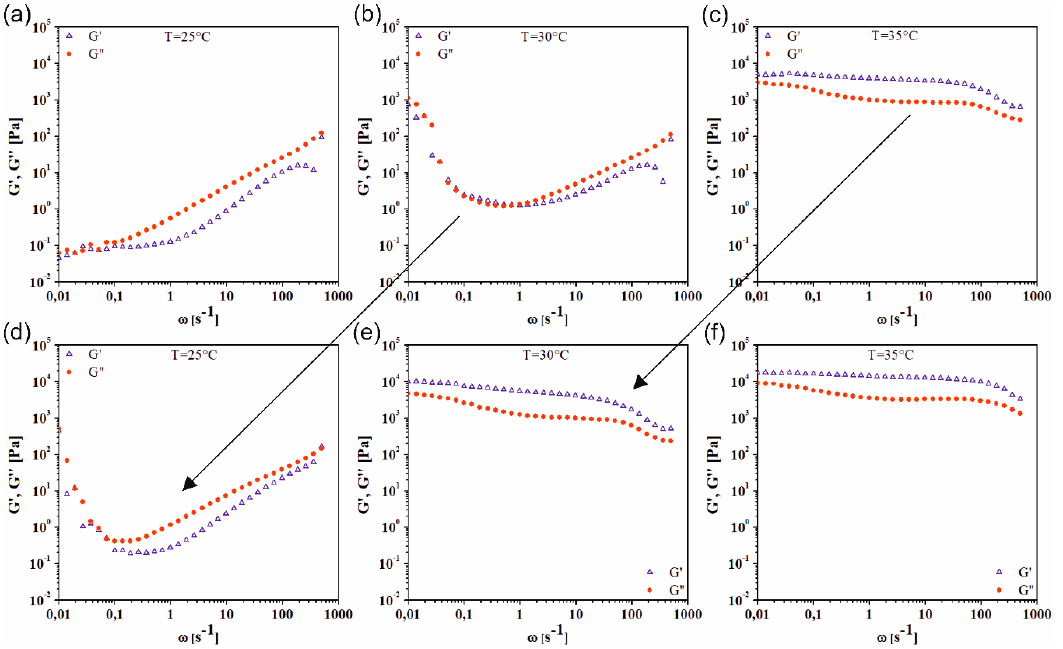
Figure 6. Comparison of experimental curves for storage G’ and loss G” moduli for sample 3 ( a – c ) and sample 3CC ( d – f ) at 25 °C, 30 °C and 35 °C. sample 3CC ( d – f ) at 25 ◦ C, 30 ◦ C and 35 ◦